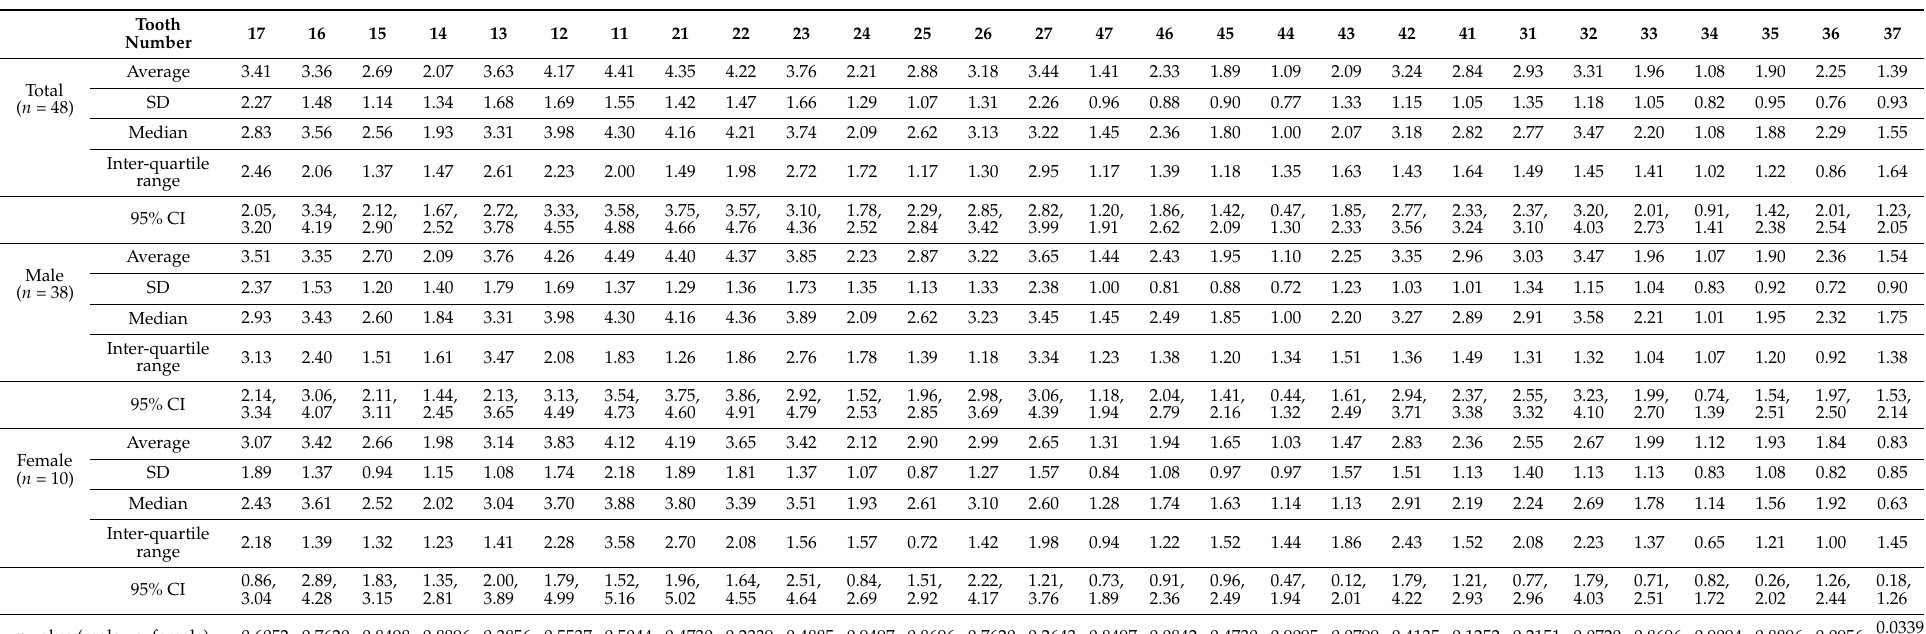
Table A2. Height of the attached gingiva (in mm).